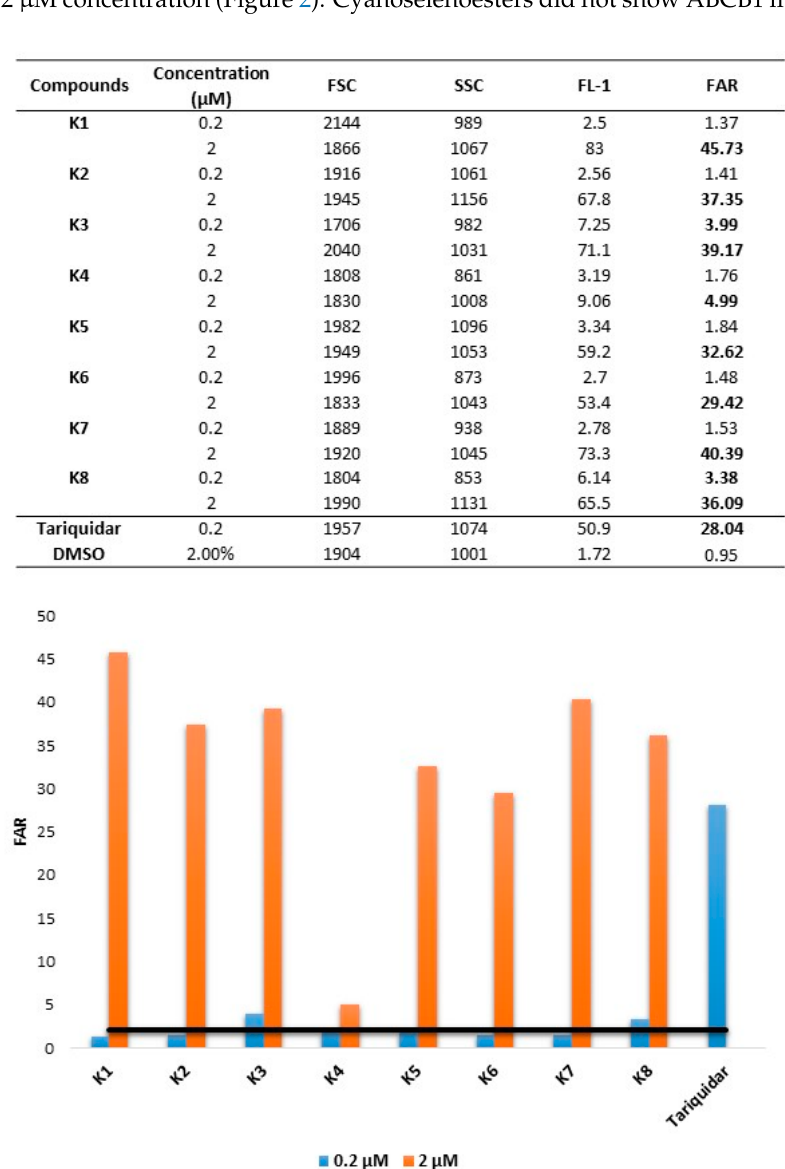
Figure 2. ABCB1 (P-gp) inhibition in the presence of selenoesters in MDR Colo 320 cells measuring the intracellular accu- mulation of the ABCB1 substrate rhodamine 123 by flow cytometry. The FAR (fluorescence activity ratio) values were calculated based on the equation given in Section 2.9. Tariquidar was applied as positive control; DMSO was used as solvent control. Results above FAR 2 (black line, highlighted in bold) are considered